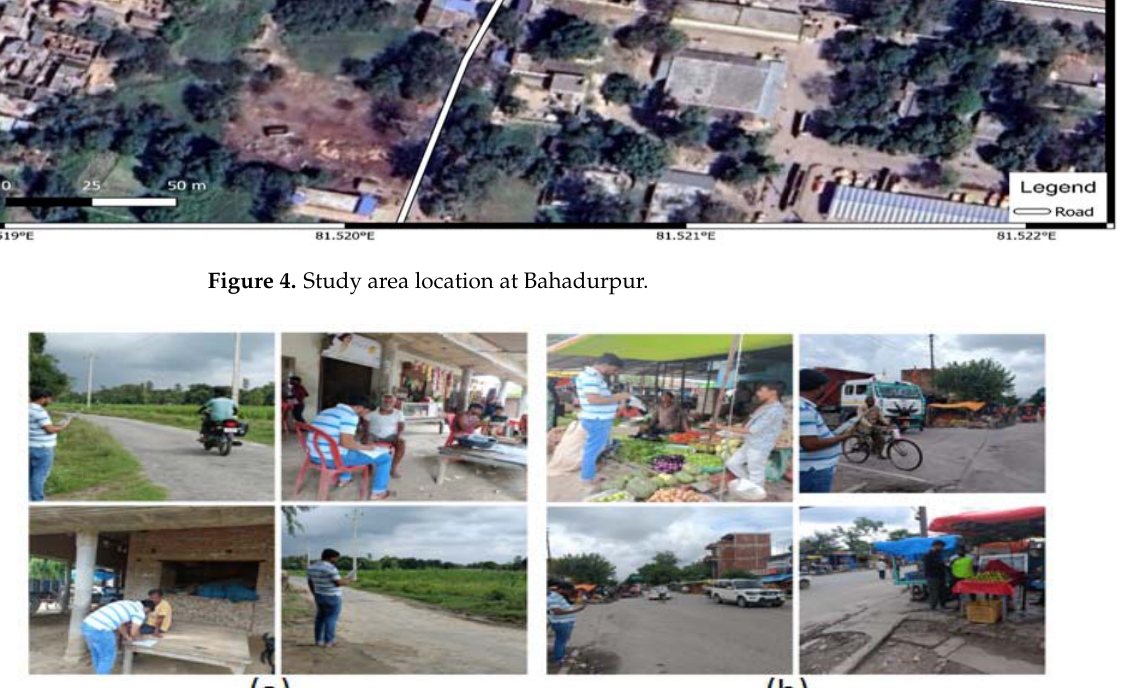
Figure 5. Data collection and questionnaire at (a) Pure Ganga Gaon (b) Bahadurpur